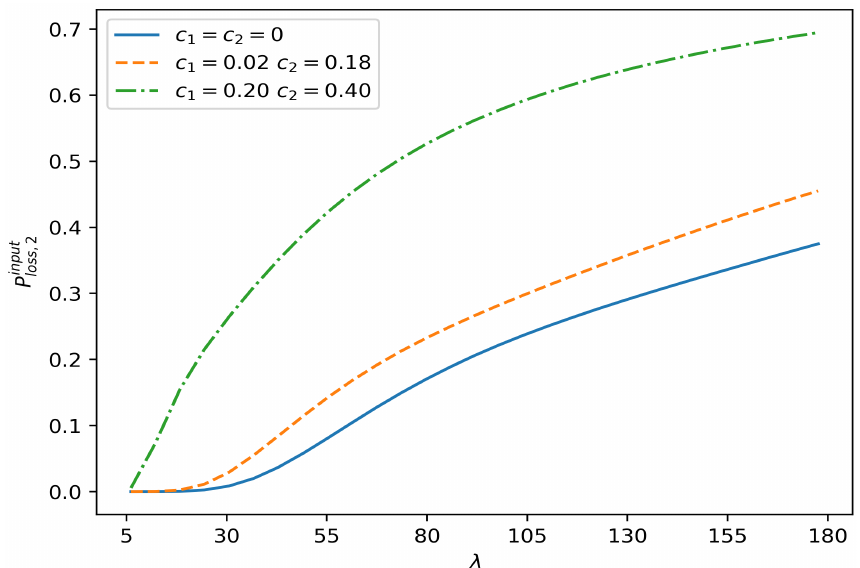
Figure 2. The dependence of the probability P input coefficients of